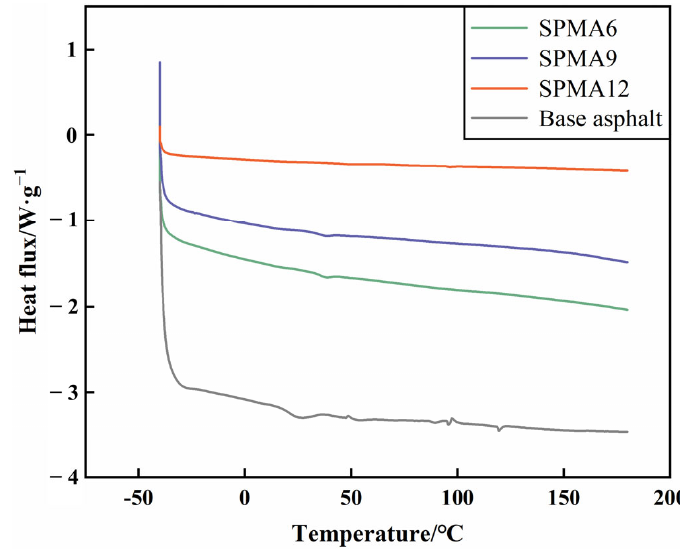
Figure 23. DSC curve of asphalt binders.